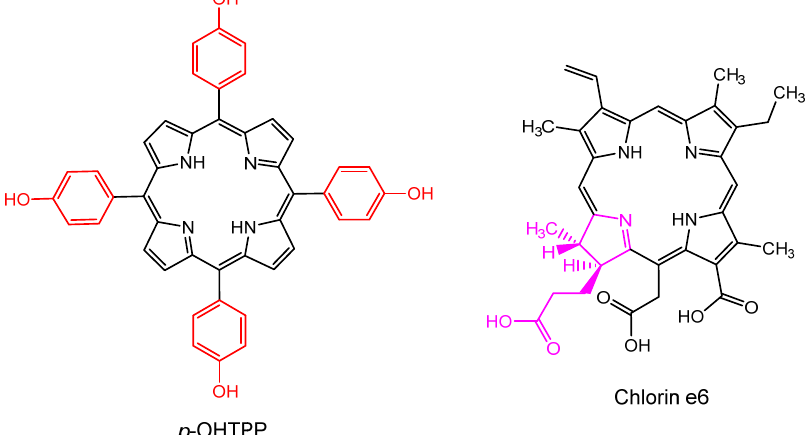
Figure 18. Molecular structures of 5,10,15,20-tetrakis(4-hydroxyphenyl)porphyrin and chlorin